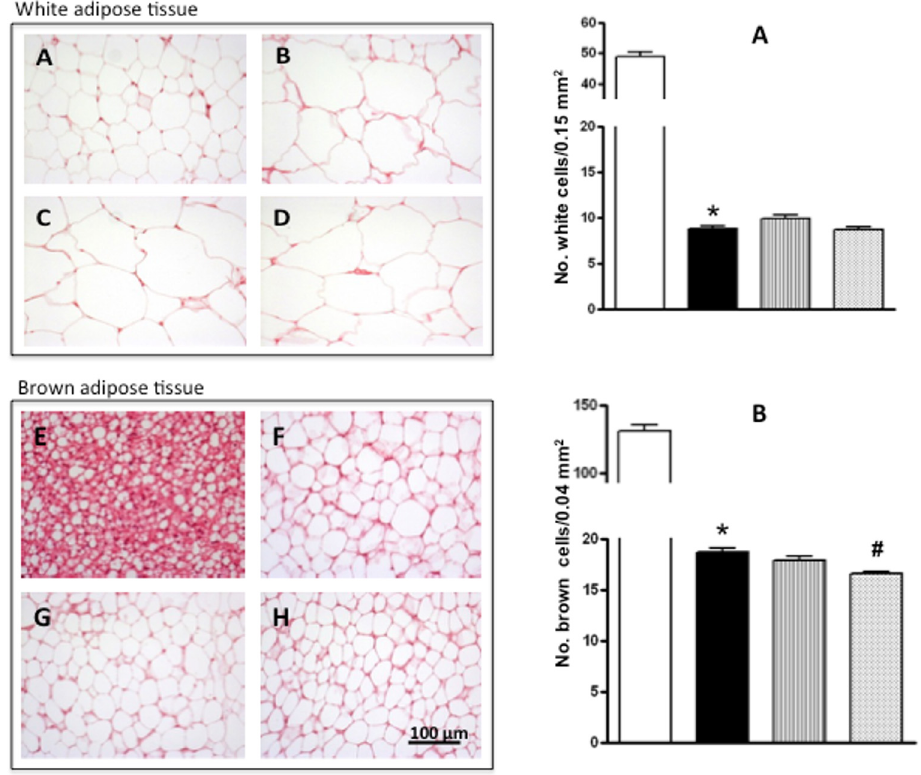
Fig 3. Histology of white and brown adipose tissue. Left : Adipocytes stained with hematoxylin-eoxin from white adipose tissue (20x, A-D) and from brown adipose tissue (40x, E-H) of lean Zucker rats (A, E) and obese Zucker rats that received water (B, F), obese Zucker rats that received 750 mg/kg/day of pepsin egg white hydrolysate (C, G) and obese Zucker rats that received 750 mg/kg/day of aminopeptidase egg white hydrolysate (D, H) for 12 weeks. Right : Number of adipocytes in the white adipose tissue (top graph) and brown adipose tissue (bottom graph) of lean Zucker rats (white), obese Zucker rats that received water (black), obese Zucker rats that received 750 mg/kg/day of pepsin egg white hydrolysate (light grey) and obese Zucker rats that received 750 mg/kg/day of aminopeptidase egg white hydrolysate (dark grey), for 12 weeks. Values are means ± SEM (n = 10). * P < 0.01 obese vs lean rats, #P < 0.01 obese rats treated with pepsin egg white hydrolysate vs control obese rats.